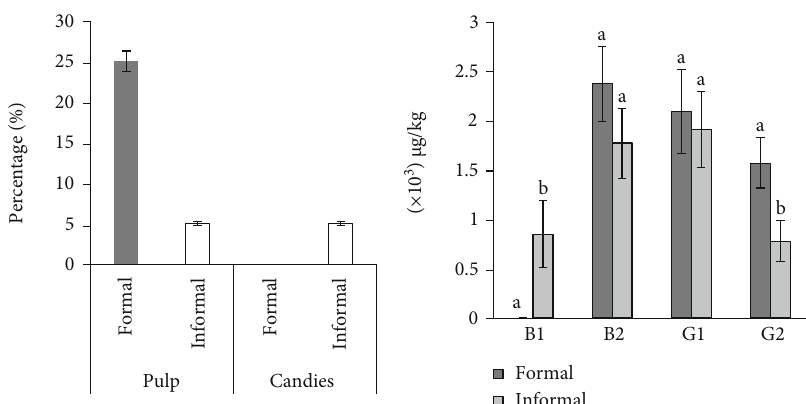
Figure 1: The percentage of a fl atoxin-contaminated samples from formal and informal baobab processors and the mean comparison of the a fl atoxin B1, B2, G1, and G2 between formal and informal processors products. Attached bars with same letters on top show no signi fi cance while bars with di ff erent letters on top show signi fi cant di ff erences. The signi fi cance levels were considered at p ≤ 0 : 05